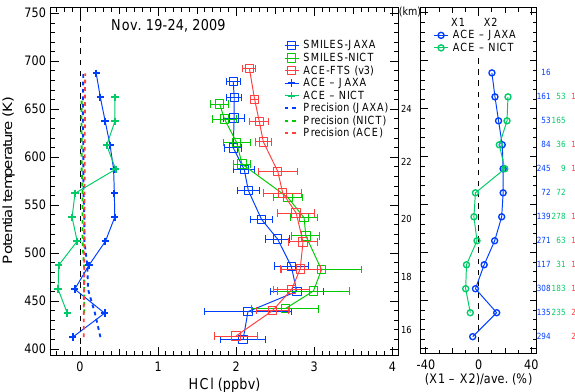
Fig. 3. Same as Fig. 2, but for SMILES and ACE-FTS. The abso- lute and relative differences between SMILES-JAXA and SMILES- NICT are